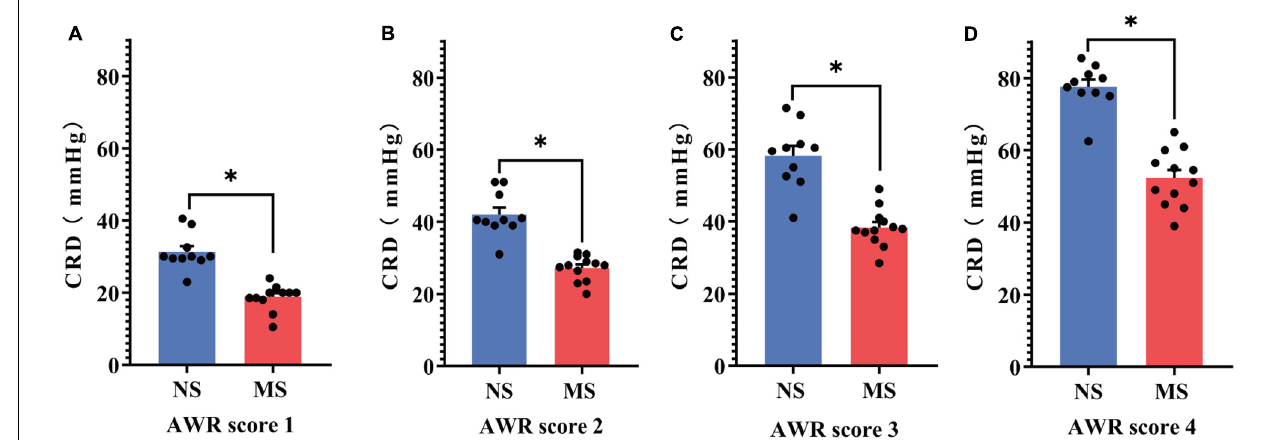
FIGURE 5 | Comparison of the threshold of AWR score between MS and NS. (A) The CRD threshold of ARW score 1. (B) The CRD threshold of ARW score 2. (C) The CRD threshold of ARW score 3. (D) The CRD threshold of ARW score 4. CRD, colorectal distention; AWR, abdominal withdrawal reflex; MS, maternal separation; NS, non-separation, ∗ P < 0.0001. MS, n = 12, NS, n = 10.